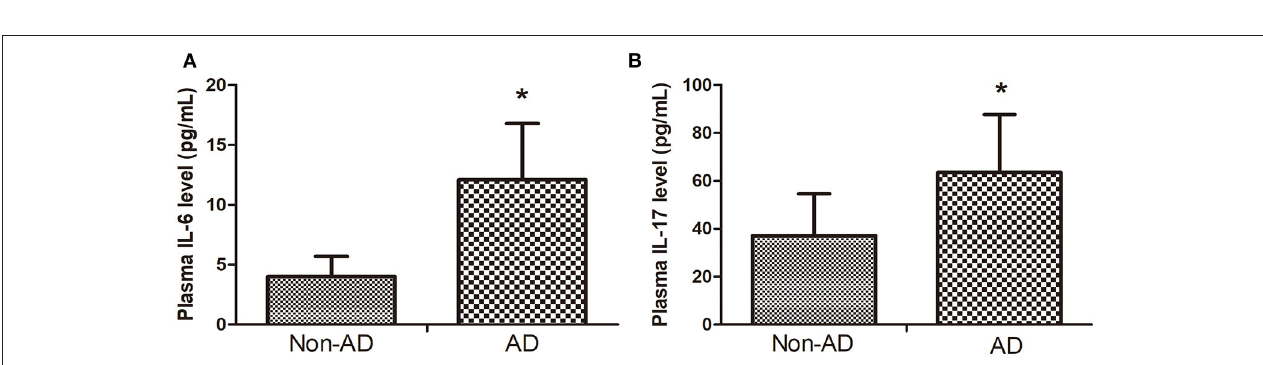
FIGURE 4 | (A) The plasma IL-6 level in AAD group was higher than that in Non-AD group. (B) plasma IL-17 level in AAD group was higher than that in Non-AD group. Data are given as mean ± SD. * p < 0.05 vs. Non-AD group.